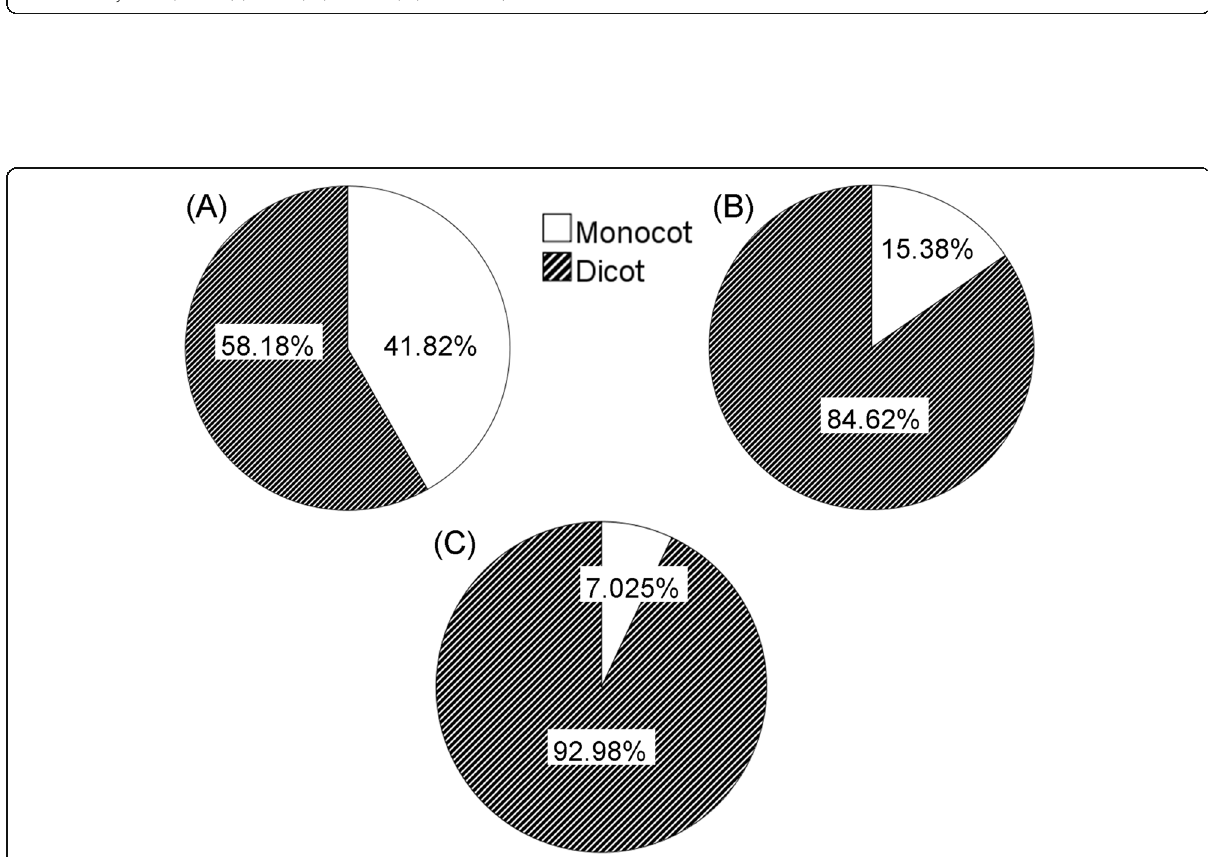
Fig. 4 Seasonal composition (%) of monocot and dicot plants in the four-horned antelope ( T. quadricornis ) diet in the tropical deciduous forests of southern Rajasthan, India ( a , winter; b , summer; c ,